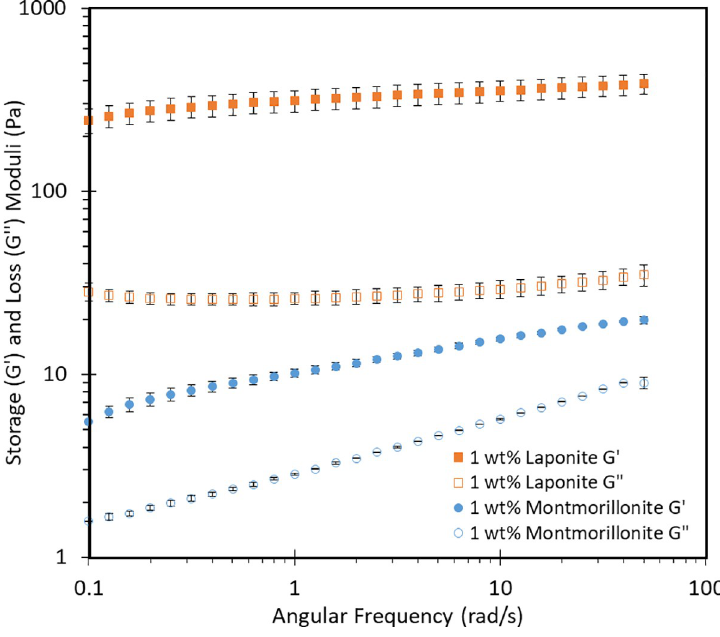
Fig 1. Frequency sweep curve of 2 wt% OCNF samples. OCNF (2 wt%) with either 1 wt% Laponite (orange squares) or 1 wt% montmorillonite (blue circles).